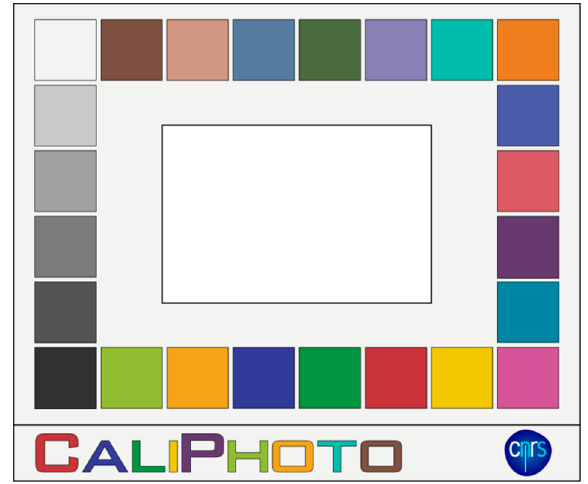
Figure A1. The ready-to-print CaliPhoto colour plate. The colour plate consists of a white 4:3 ratio rectangle (without the CaliPhoto logo line), surrounded by 24 squares of different colours arranged in a rectangle, surrounding another white rectangle. The centre of the printed colour plate must be cut out and removed in order to obtain the rectangular window in which the sample will be observed.